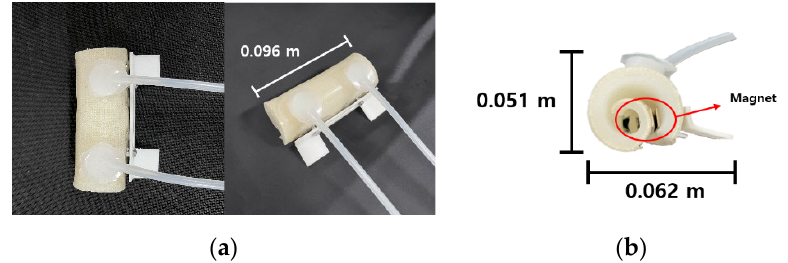
Figure 14. Final design of soft jumping robot. ( a ) Attachment position of front foot; ( b ) magnet for drive stabilization of soft jumping robot.